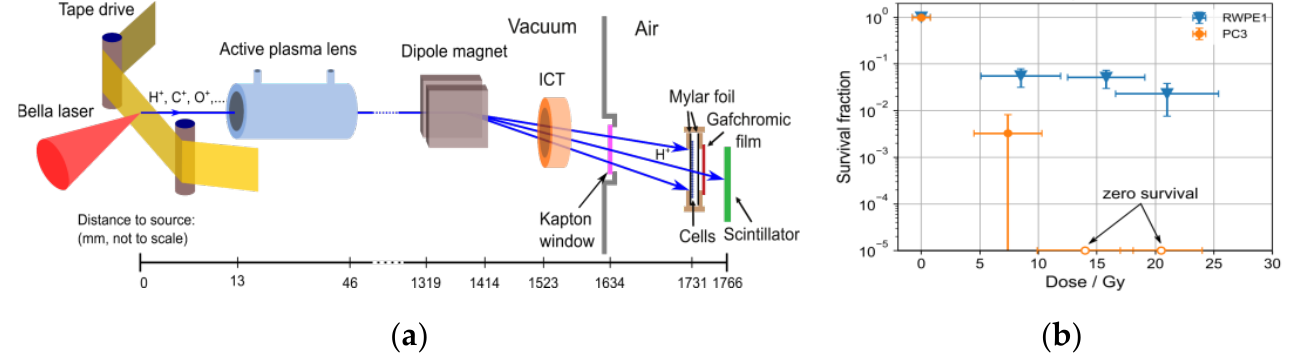
Figure 10. Figure adapted from Ref. [89]. ( a ) Schematic depiction of the laser-driven proton beamline at the BELLA PW laser with tape-drive target, active plasma lens, dipole magnet, integrating current transformer (ICT), cell sample, radiochromic film, and scintillator. ( b ) Cell survival fraction of human prostate cancer cells (PC3) and normal human prostate cells (RWPE1) after irradiation with laser-driven protons. (J. Bin, et al. Sci Rep. 2022 Jan 27;12(1):1484. doi: 10.1038/s41598-022-05181-3, reproduced with permission under the terms of the Creative Commons Attribution License (CC BY), http://creativecommons.org/licenses/by/4.0/). Table 3. Proton beam parameters for cell sample irradiations at the BELLA PW. Beam Parameter Value Dose per pulse 1 Gy Pulse length 30 ns Pulse repetition rate